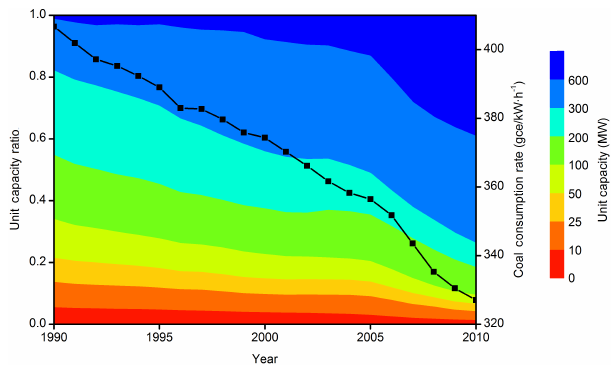
Figure 1. Trends in generation mix by capacity and the average coal consumption rates (black line) during